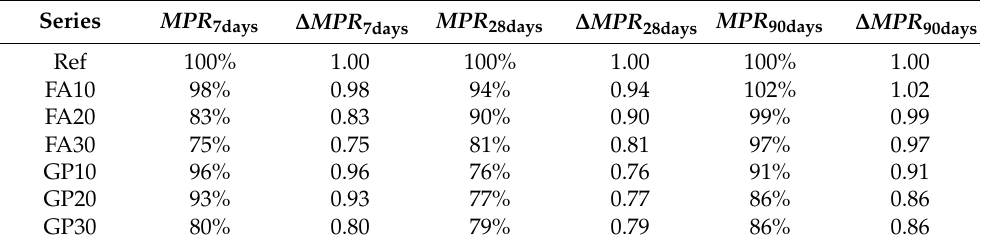
addition of the fly ash and granite powder.